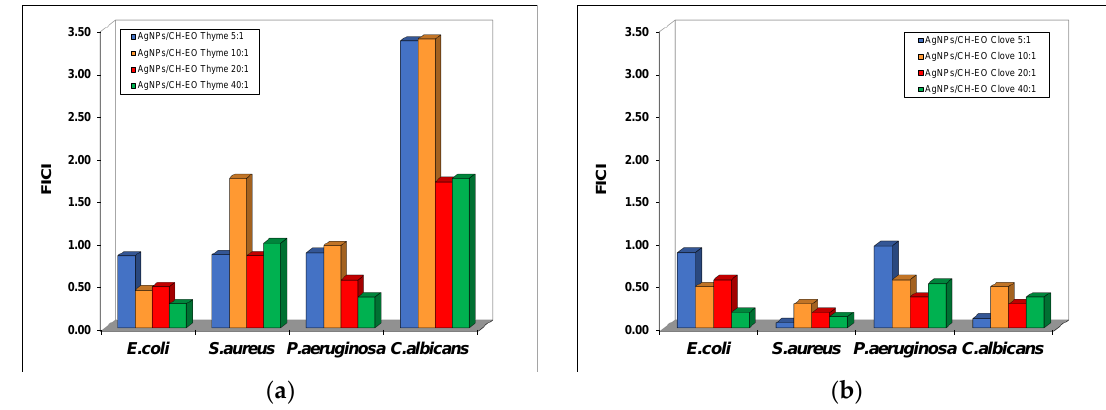
Figure 9. The variation of the fractional inhibitory concentration index (FICI) of mixed systems with AgNPs stabilized with 1% LMW chitosan and essential oils. ( a ) Thyme oil; ( b ) Clove oil.